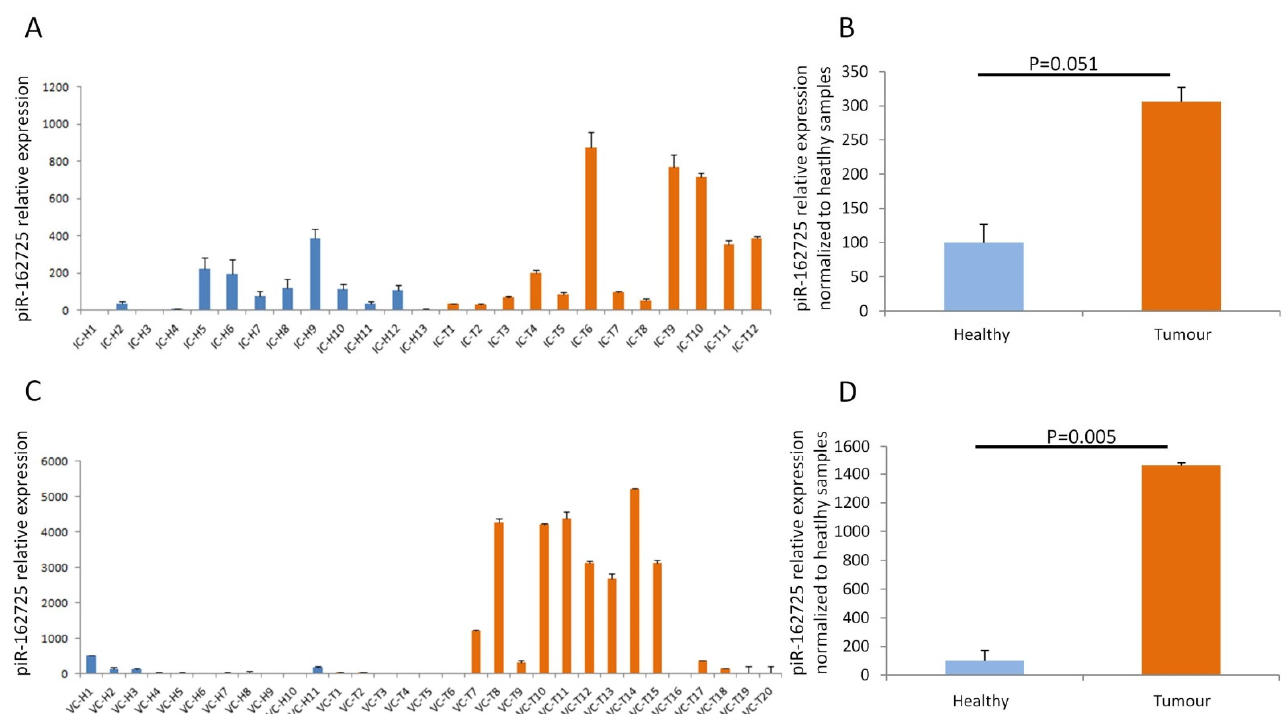
Figure 3. Expression of piR-162725 in human plasma samples. ( A ) Relative piR-162725 expression in plasma samples from healthy donors and PDAC patients recruited institutionally. ( B ) Statistical analysis of piR-162725 expression in plasma samples from our institutional cohort grouped by their status, i.e., healthy or tumour. ( C ) Relative piR-162725 expression in plasma samples from healthy donors and PDAC patients from a validation cohort. ( D ) Statistical analysis of piR-162725 expression in plasma samples from the validation cohort grouped by healthy or tumour status. IC-H: Institutional cohort healthy samples. IC-T: Institutional cohort tumour samples. VC-H: Validation cohort healthy samples. VC-T: Validation cohort tumour samples. p -values < 0.05 were considered statistically significant.